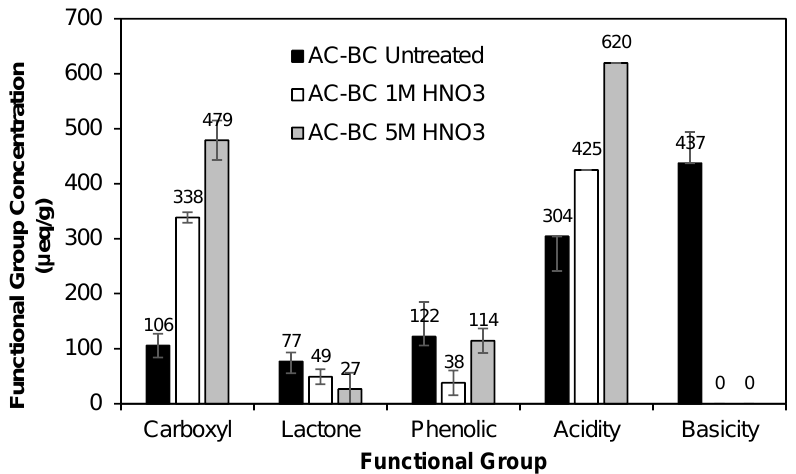
Figure 4. Boehm titrations of bituminous coal-based activated carbons and their nitric acid-treated counterparts.